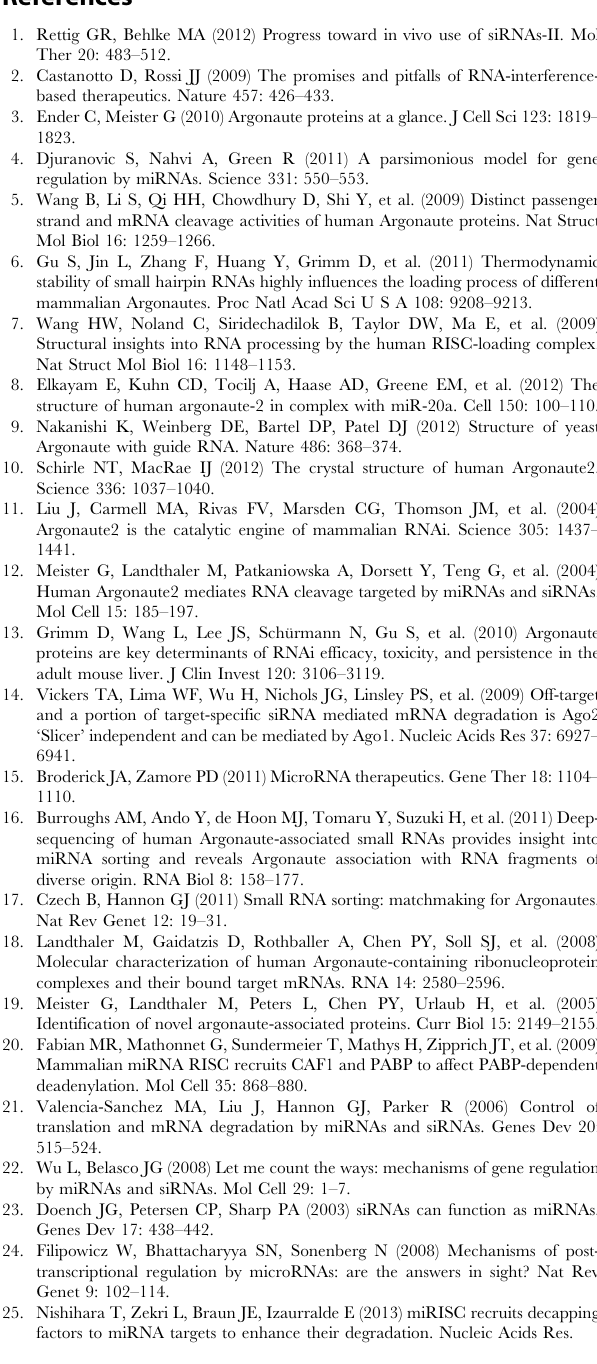
Table S1 Sequences and relative target-site positions of siRNAs. (XLS) Table S2 Relative Argonaute mRNA abundance.